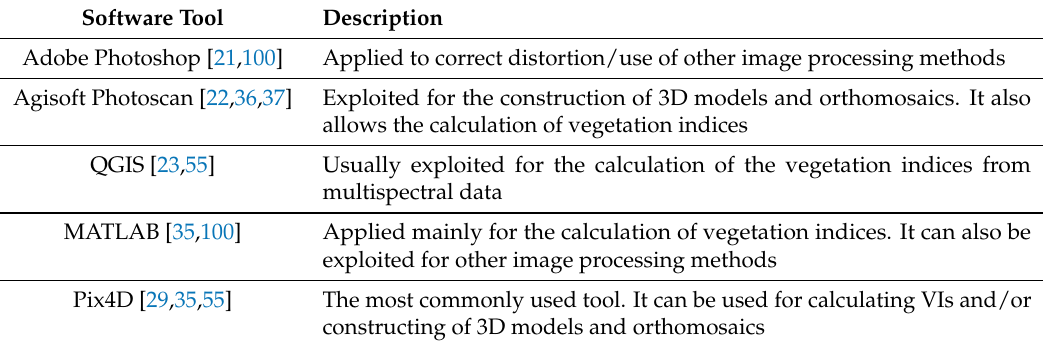
Table 2. Most common software tools used in the literature for image